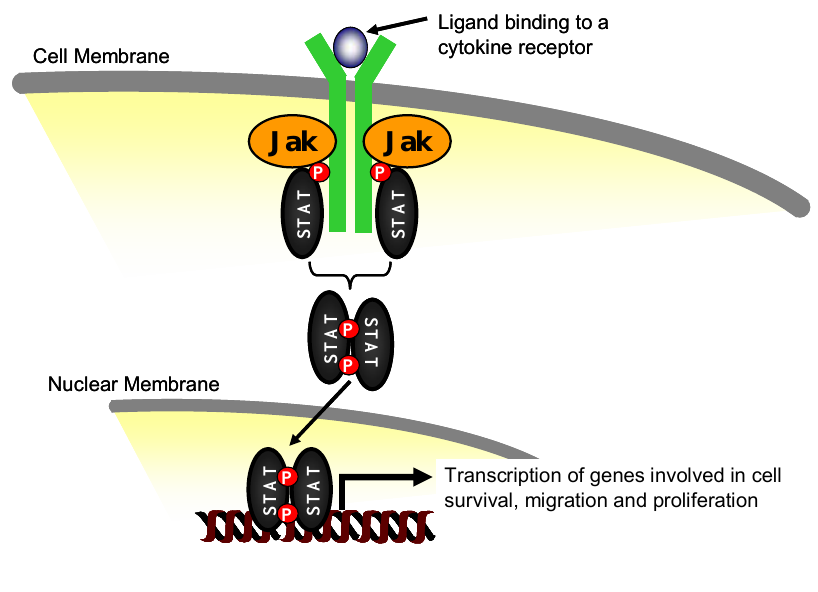
Figure 1. The Classical Jak/STAT Signaling Pathway. Ligand binding causes cytokine receptors to dimerize which results in Jak phosphorylation, recruitment of the Signal Transducer and Activator of Transcription (STAT) signaling proteins, which are then tyrosine phosphorylated by the Jaks. The phosphorylated STATs dimerize, and translocate into the nucleus where they bind to cis- inducible promoter elements to stimulate gene